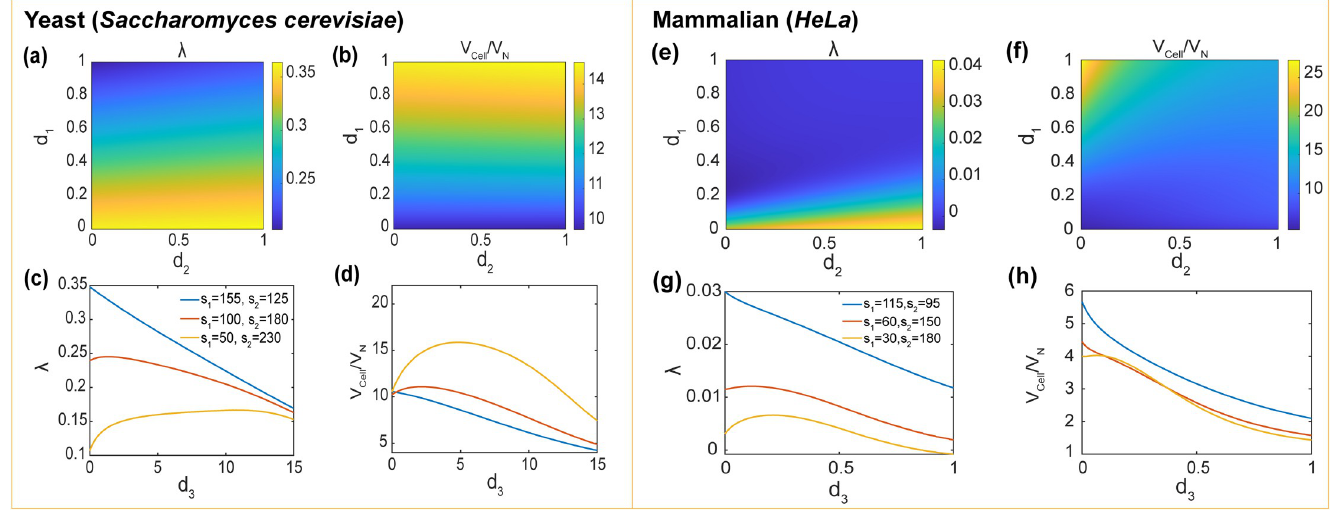
Fig 5. Effects of protein degradation and ribosome disassembly on cell growth and the C/N ratio. (a)-(b) effects of degradation on growth rate and C/N ratio. (c)- (d) Non-monotonic influences of disassembly on growth rate in different ribosomal protein synthesis levels. (e)-(h) Corresponding results for mammalian cells. All parameters except scanned parameters are listed in Table